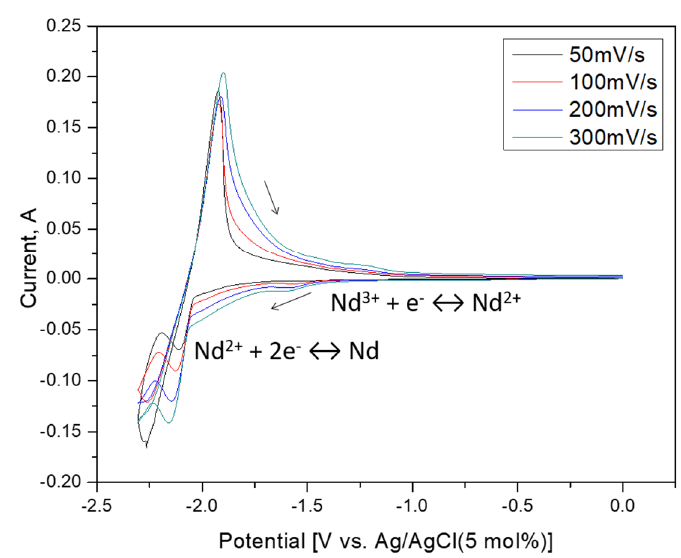
Figure 5. Cyclic Voltammograms of 4 wt% NdCl 3 in LiCl-KCl eutectic molten salt with scan rate; 50, 100, 200, 300 mV/s at 773K.